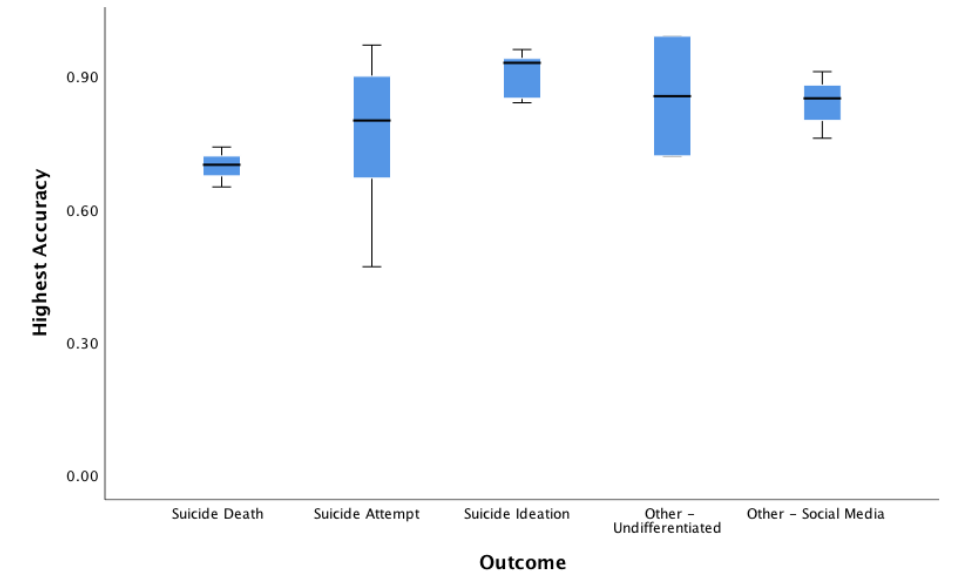
Figure 2. Boxplot of accuracy by suicide outcome. Boxplot of classification accuracy by suicide outcome